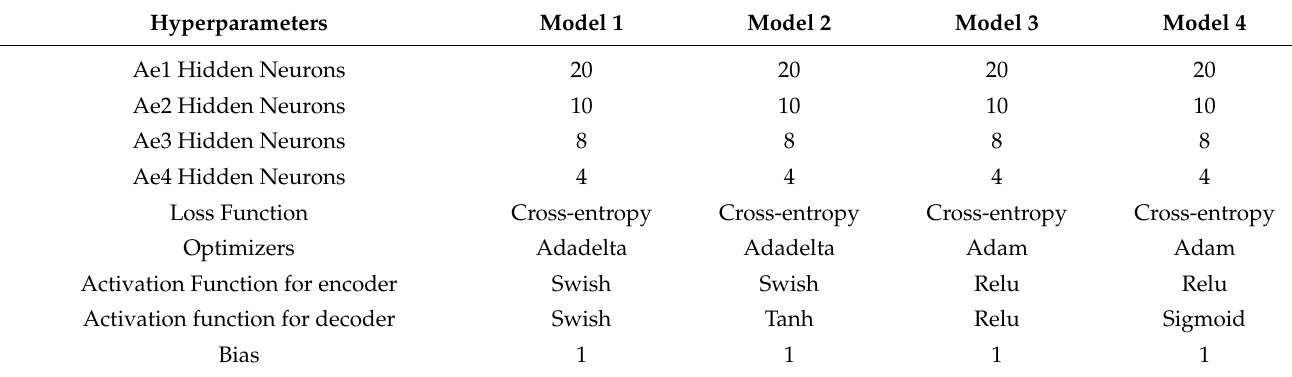
Table 3. Detailed information regarding the layers and parameters of the SAE.